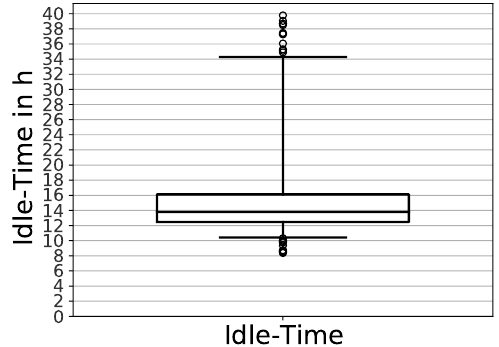
Figure 8. Idle time for the logistics